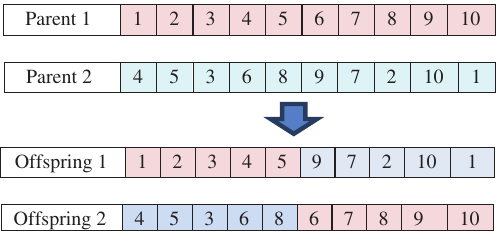
Figure 7: Example of Single-Point Crossover.